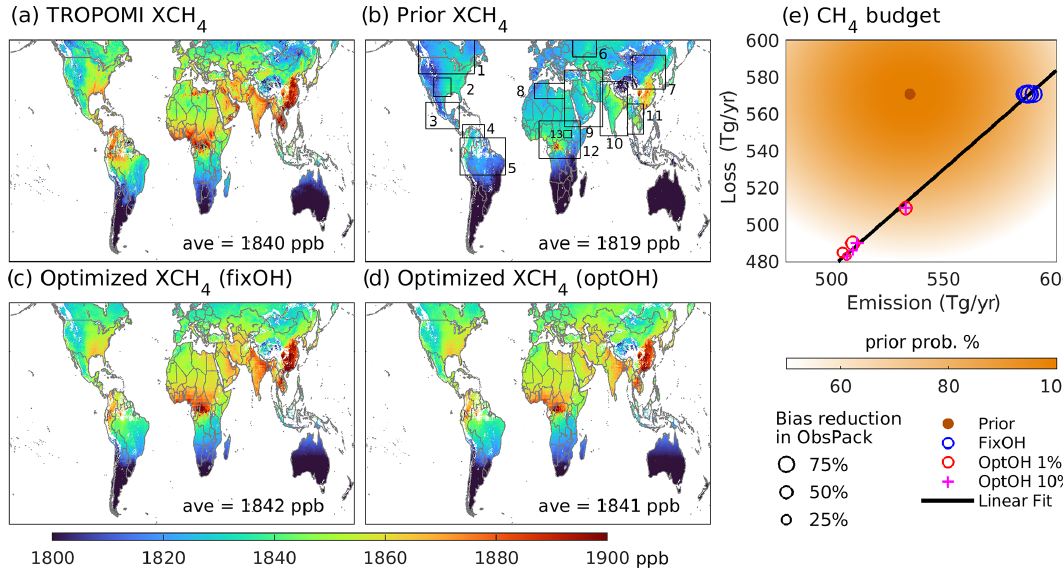
Figure 2. Observed and simulated methane distributions for March 2018–February 2020. (a) TROPOMI methane column (XCH 4 ) obser- vations oversampled to 0.1 ◦ × 0.1 ◦ . (b) Methane column distribution predicted by the prior model sampled according to the TROPOMI observation operator with numbered regions described in the text. (c) The same as panel (b) but for the fixOH optimized ensemble mean. (d) The same as panel (b) but for the optOH optimized ensemble mean. (e) Prior and optimized methane budgets. Prior probabilities (orange) equate 1 standard deviation to 25% of the bottom-up range from Saunois et al. (2020), following Hozo et al. (2005). The black line shows a linear fit to the solution, emission = 0.93 × loss + 55.26 (units: Tgyr − 1 ). Symbol sizes indicate the mean bias reduction against ObsPack in- dependent measurements. Annual values are for November 2018–April 2019 plus the average of May–October 2018 and May–October